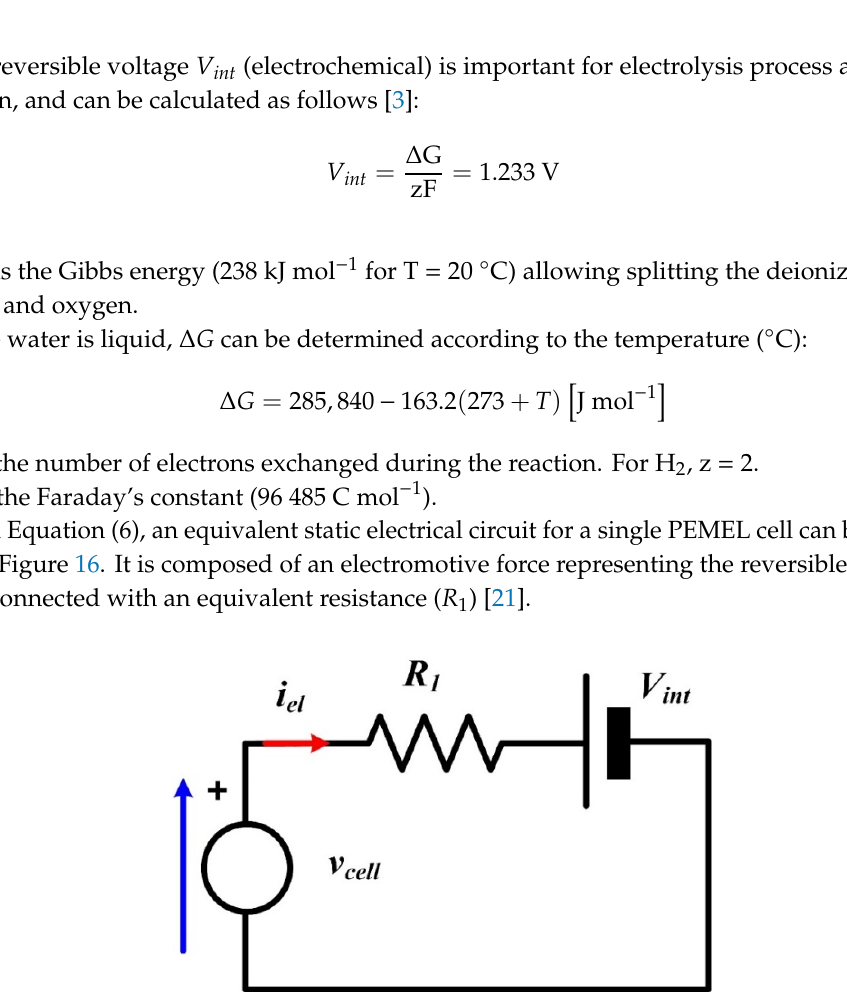
Figure 16. Equivalent static electrical model of a proton exchange membrane electrolyzer (PEMEL) single cell.